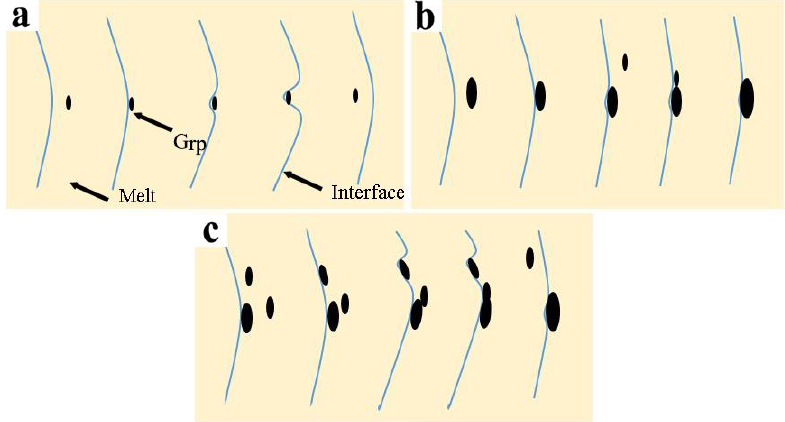
Figure 19. Illustration of the relationship between the solidification interface and the particles: ( a ) Grp swallowed by the interface; ( b ) Grp rejected by the interface; ( c ) Grp swallowed or rejected by the interface.